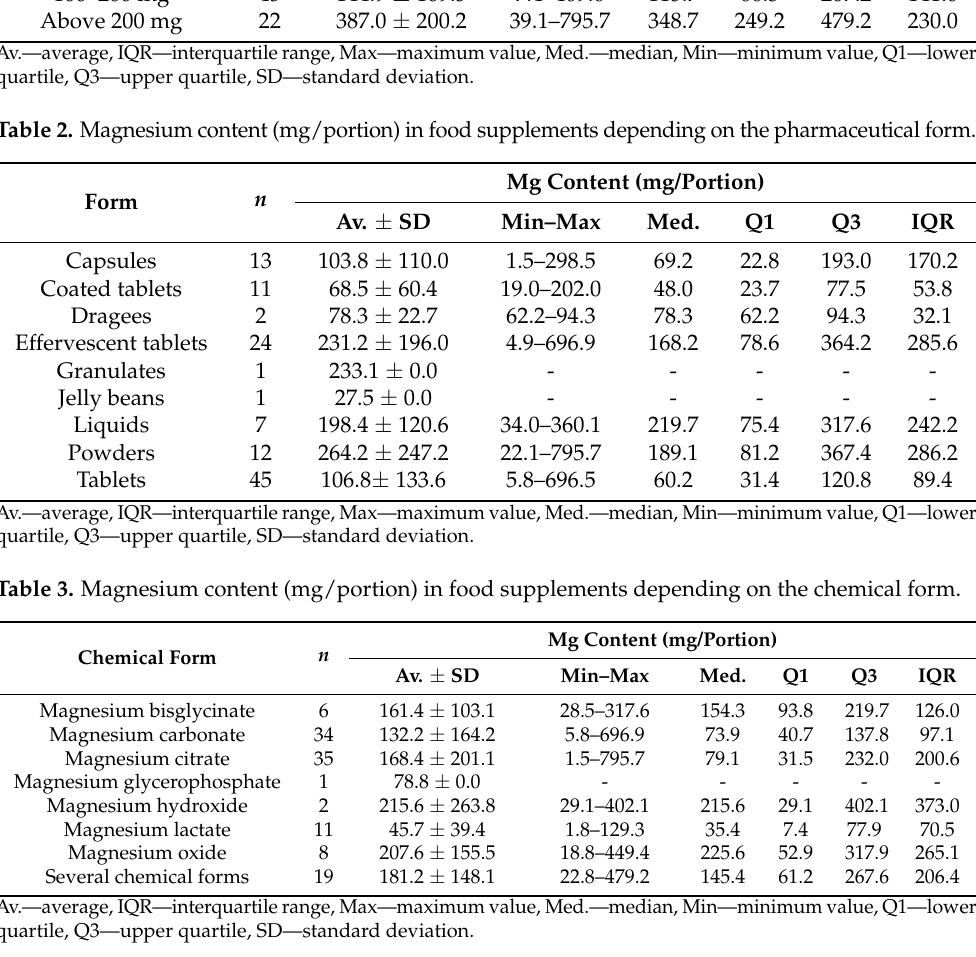
Table 4. Magnesium content (mg/portion) in food supplements depending on the amount of minerals.